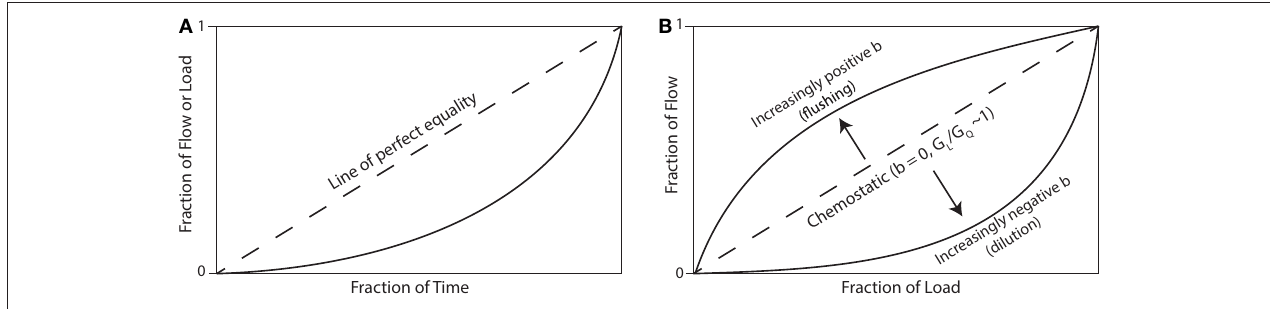
FIGURE 2 | Schematics of (A) Lorenz curves and (B) dual Lorenz curves for load versus flow, as modified from Jawitz and Mitchell (2011) and Gall et al. (2013). The shape of the curves are determined by the Gini coefficient for load and discharge, where perfect equality is G = 0 and perfect inequality is G = 1, and can be used to indirectly evaluate concentration-discharge relationships.